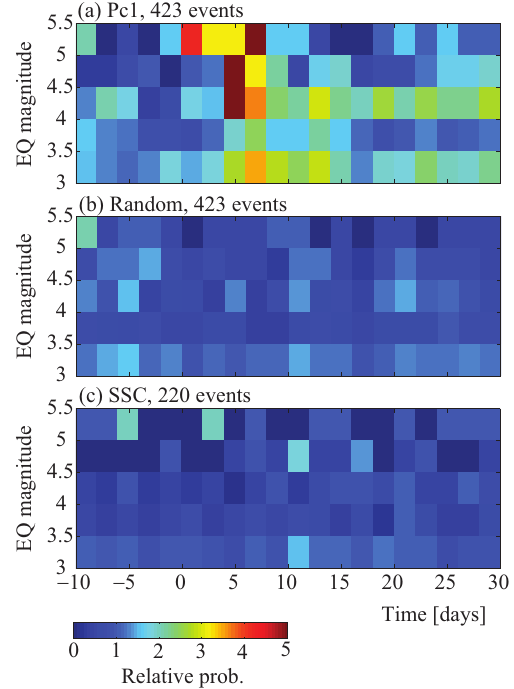
Fig. 7. Superposed epoch analysis of relative probability of observ- ing earthquakes, parameterized by time and earthquake magnitude, relative to (a) mid-day Pc1 events, (b) random event sequence, and (c) Storm sudden